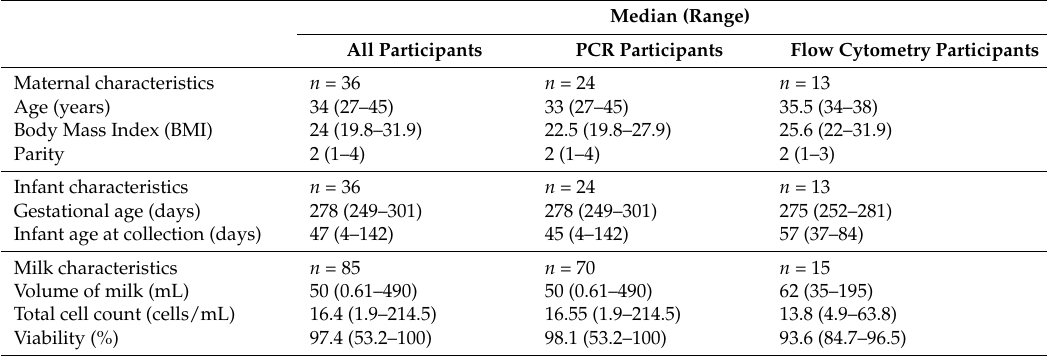
Table 1. Demographics of study participants engaged in the